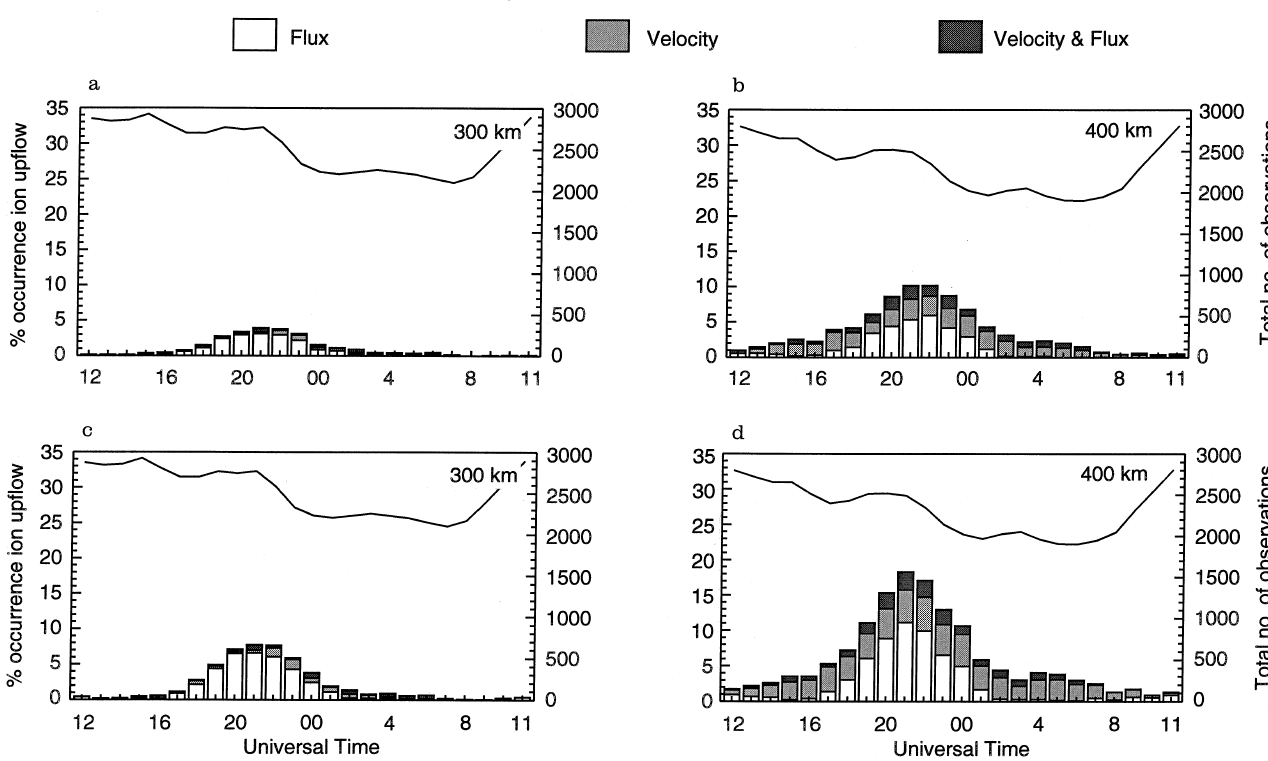
Fig. 7a–d. Diurnal distributions of upflow simultaneous with ion frictional heating events at a 300 and b 400 km. c same as Fig. 1c, d same as Fig.